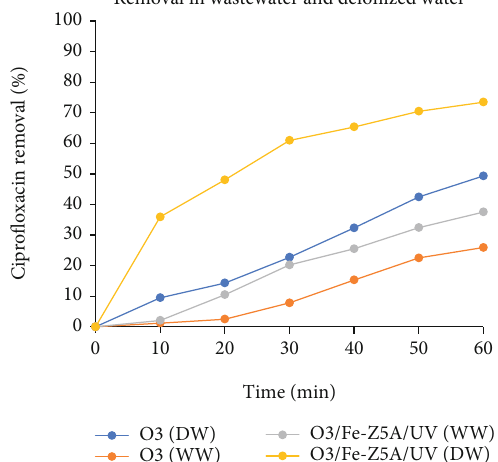
Figure 8: Comparison of cipro fl oxacin removal in municipal wastewater and deionized water using O ( C = 50 mg/L ; COD = 104 mg/L ; pH o ð cipro Þ = 0 : 9mg/L ; volume = 2 : 5 L ; catalyst dose = 25 g : T = 7 : 2 ± 0 : 2 ; O 3 60 min